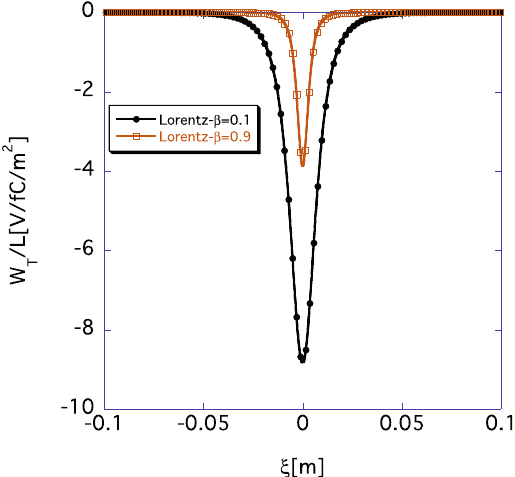
Figure 3. Lorentz- β dependence of the wake function W T ( ξ ) according to Eq. (23), where σ z = 0, r b = 10 mm, and a = 40 mm. The black and brown lines show W T ( ξ ) for β = 0.1 and 0.9, respectively.